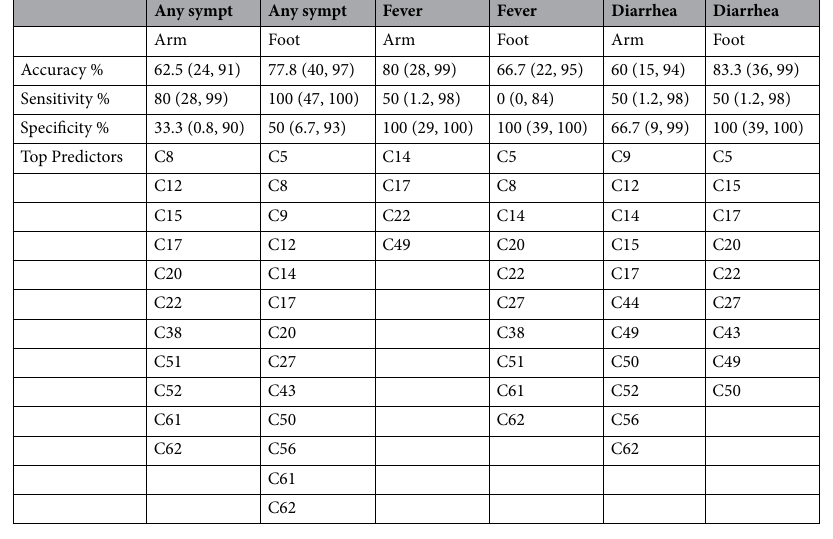
Table 3. Performance of trained models and 95% confidence intervals when used to predict malaria- uninfected symptomatic (SU) vs. malaria-uninfected asymptomatic (ASU) children in the test set. SU with any symptom n = 22, fever n = 11, diarrhea n = 9. ASU n = 16.